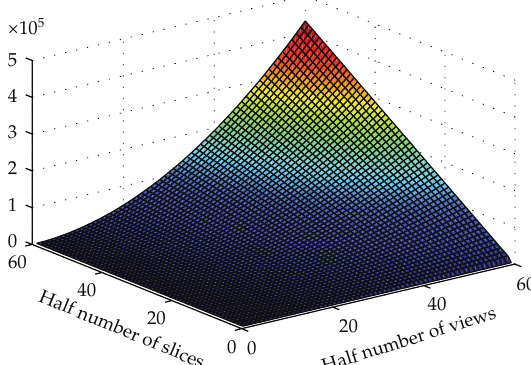
Figure 4: Numbers of polygonal dependence with the numbers of views and slices.